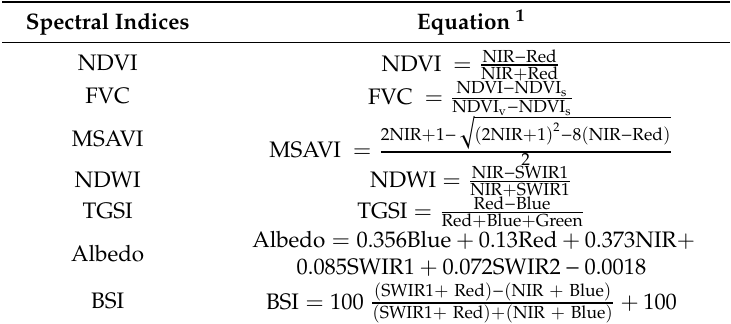
Table 3. Spectral indices and their formulas.